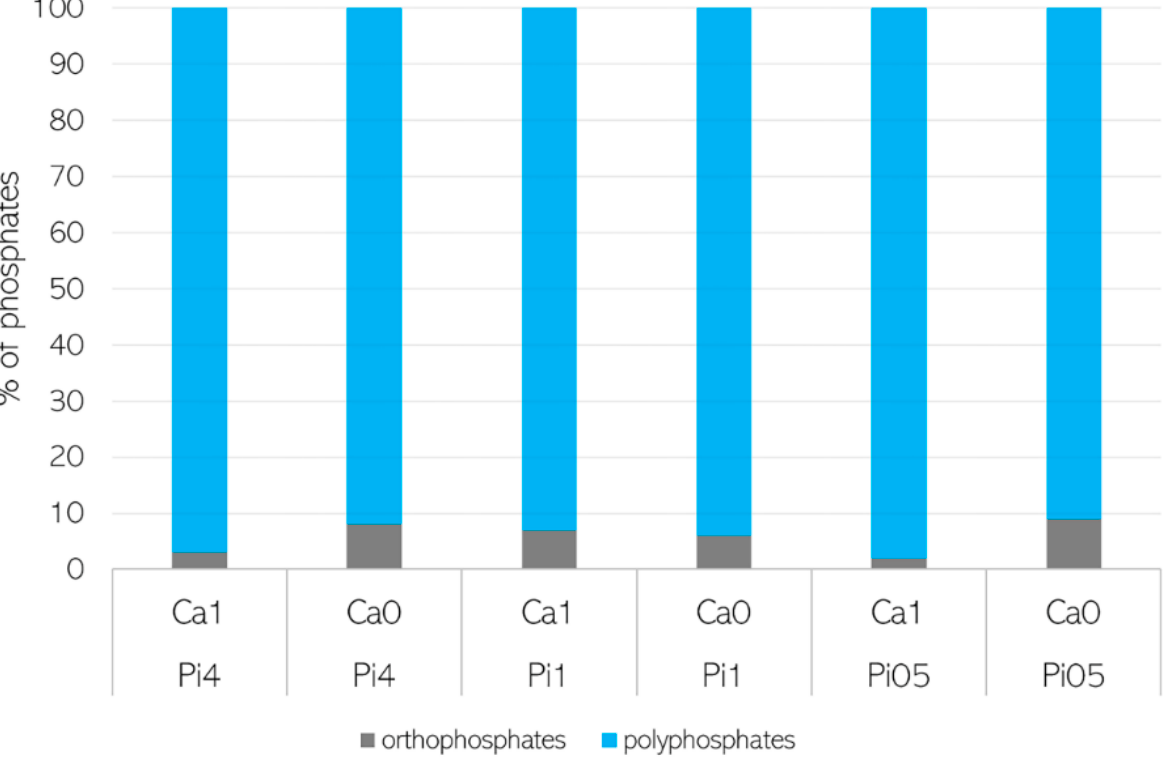
Figure 5. The characterization of cellular phosphates in Mucor circinelloides VI 04473 biomass.